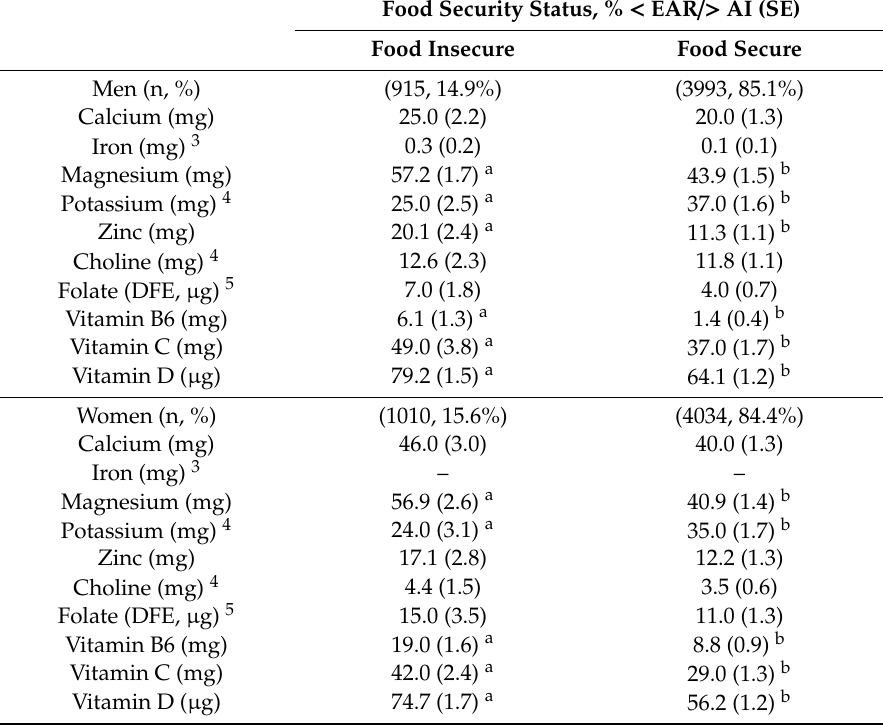
Table 2. Proportion of the population falling below the Estimated Average Requirement or above the Adequate Intake from total usual nutrient intakes of select nutrients, by food security status, among adults ( ≥ 19 years) in the U.S., 2011–2014.